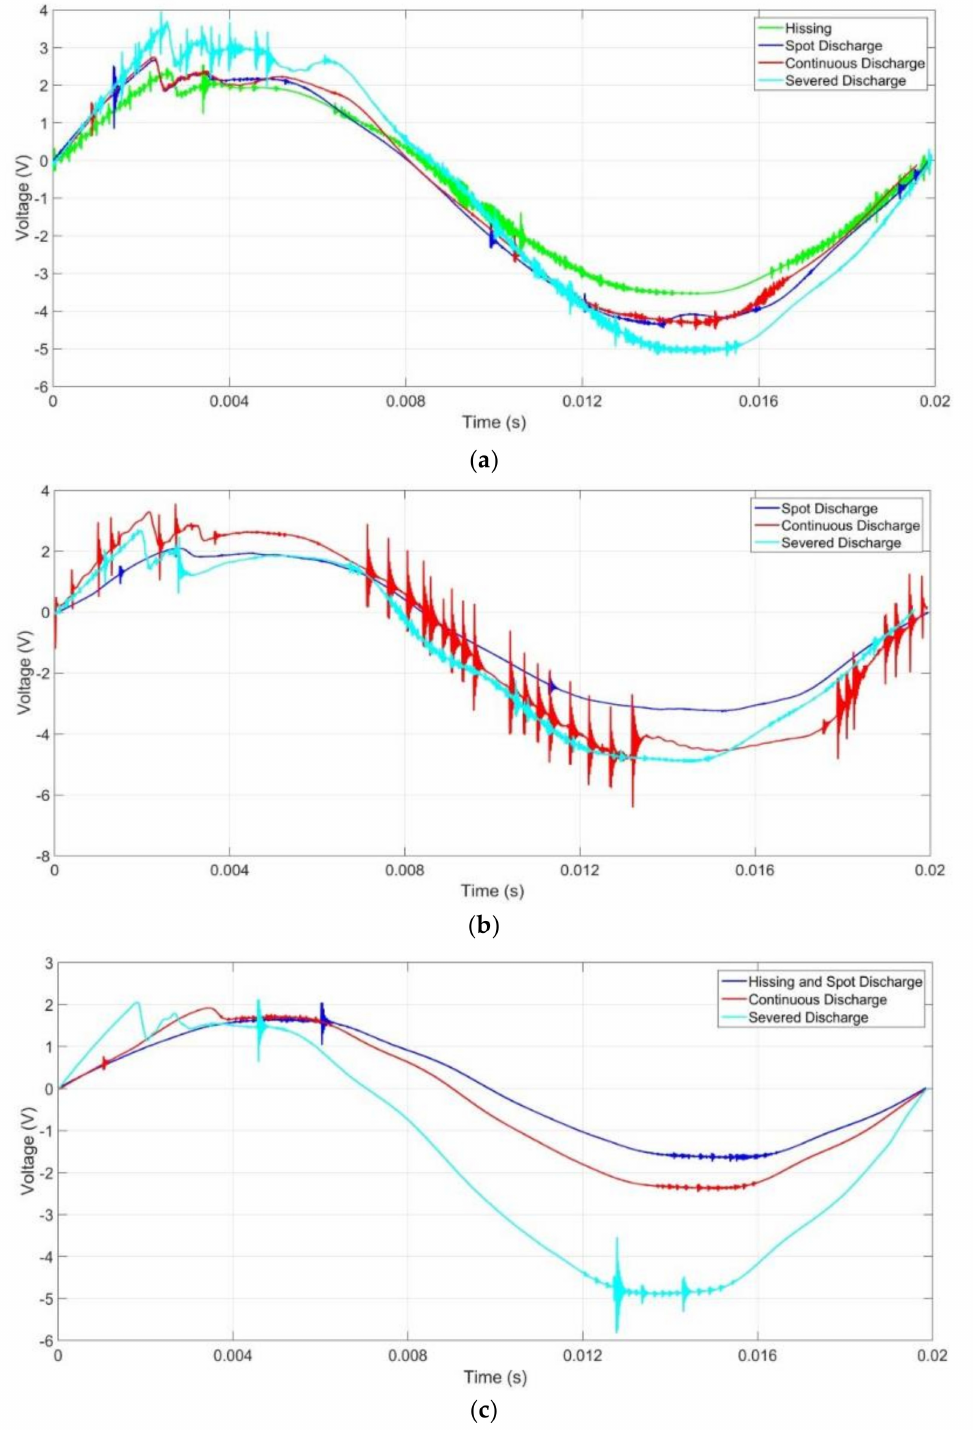
Figure 12. UV signals for insulator samples under wet conditions with light contamination level: ( a ) Group A; ( b ) Group B; ( c ) Group